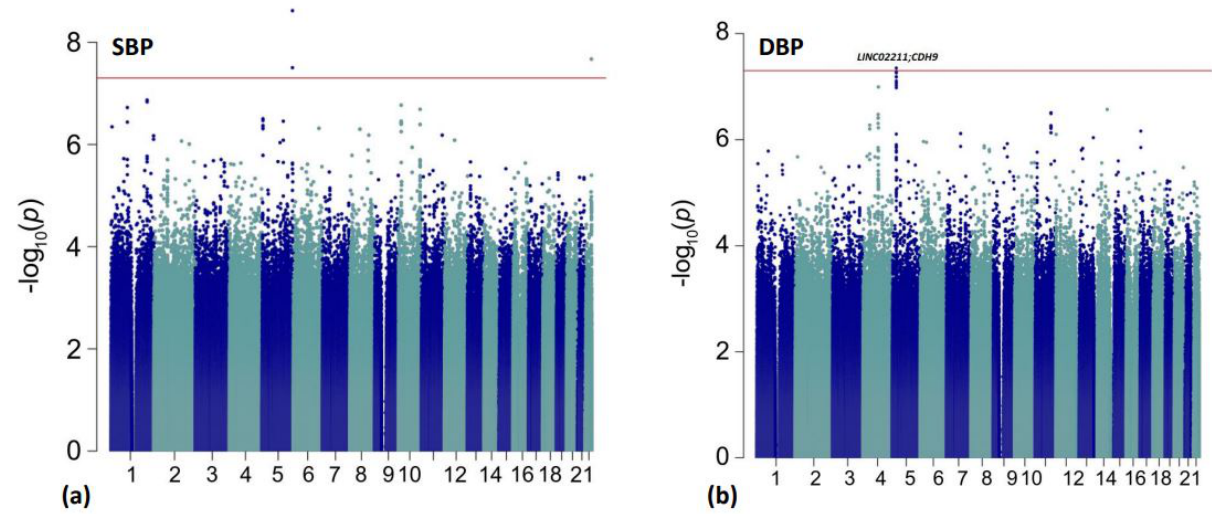
Figure 1. Manhattan plots for the primary discovery analyses for BP response. The red line is representative of genome-wide significance ( p < 5.00 × 10 − 8 ). Results are shown from ( a ) ∆ SBP analysis; ( b ) ∆ DBP analysis.